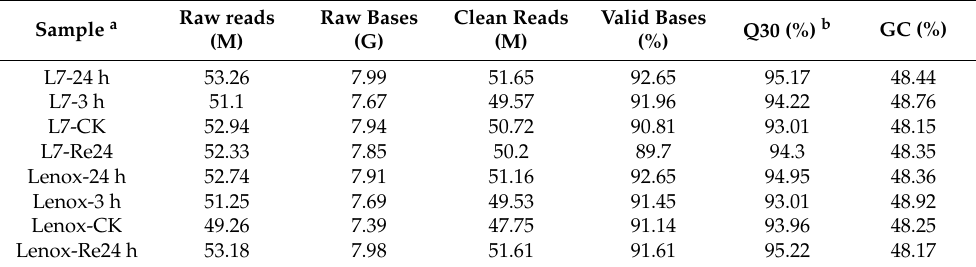
Table 1. Summary of quality preprocessing of RNA sequencing data.